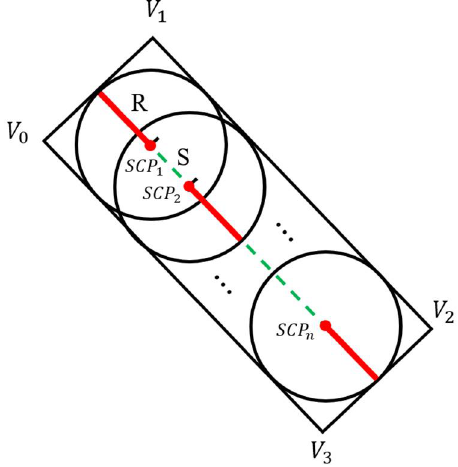
Figure 3. How ship center points (SCPs) are selected.